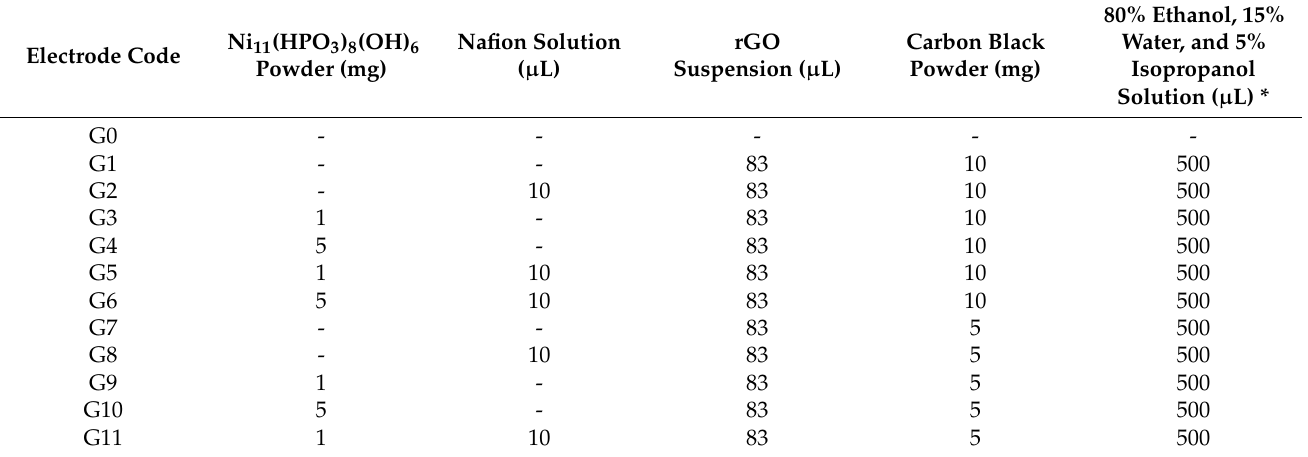
Table 1. The codes used to identify the electrodes, together with the compositions of the suspensions employed to modify the graphite